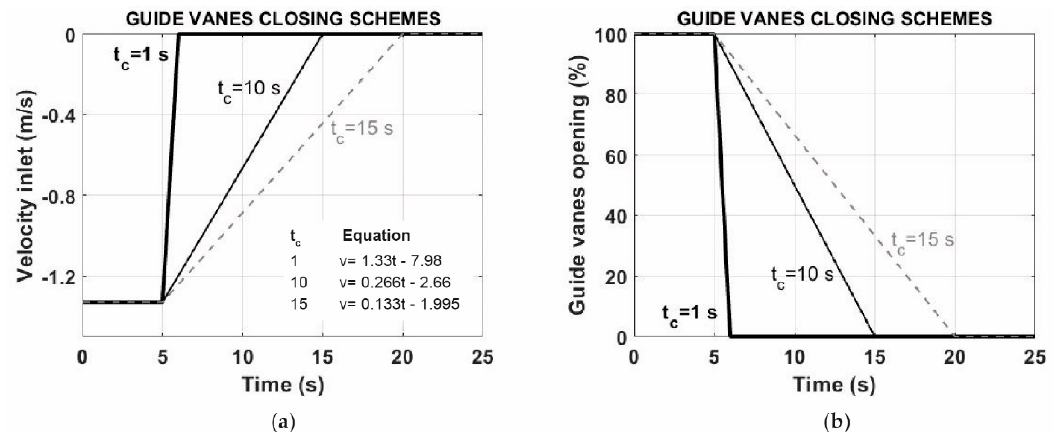
Figure 3. Guide vanes linear closing schemes. ( a ) Variation of velocity inlet in pumping mode for t c = 1, t c = 10 and t c = 15 s; ( b ) Guide vanes opening variation for t c = 1, t c = 10 and t c = 15 s. Table 3. Water and air properties considered in the numerical simulations. Pressure outlet boundary condition was considered at the exit of the ventilation shaft, while assuming a stable pressure value that corresponds to the standard atmospheric pressure (101.3